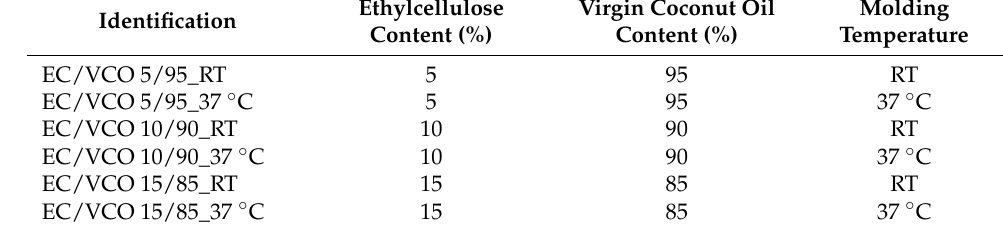
Ethylcellulose Content (%)